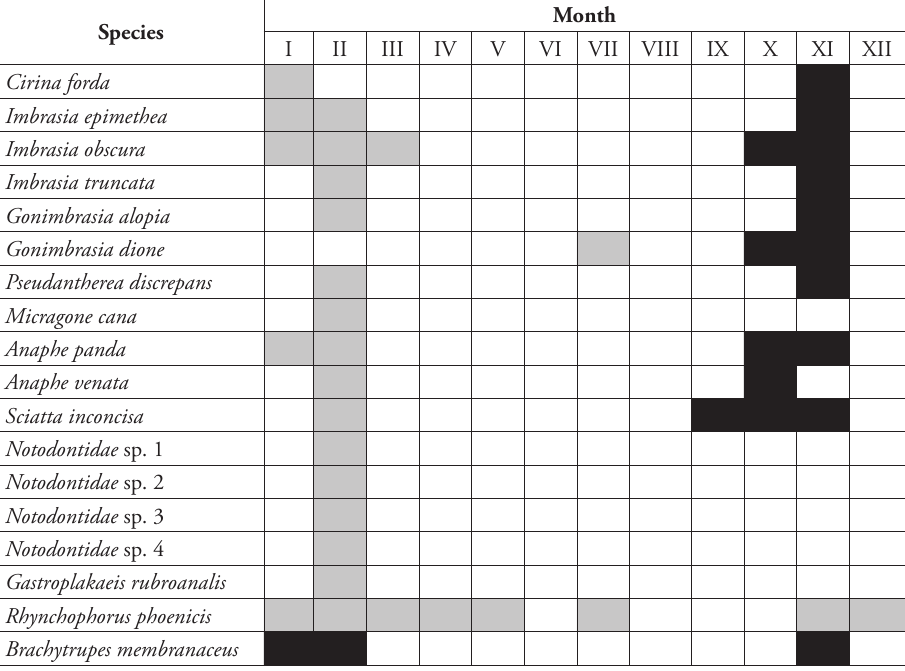
Table 3. Phenology of collected edible insect species, based on collected samples: grey larvae, black